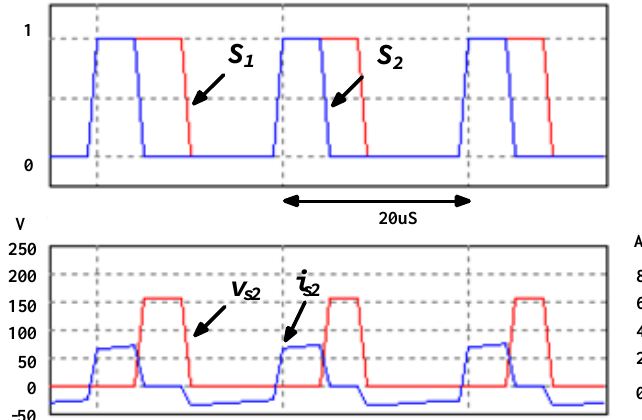
Figure 16. Simulation results for (top) switching control signals and (bottom) corresponding voltage and current of switch S 2 during positive half line cycle.